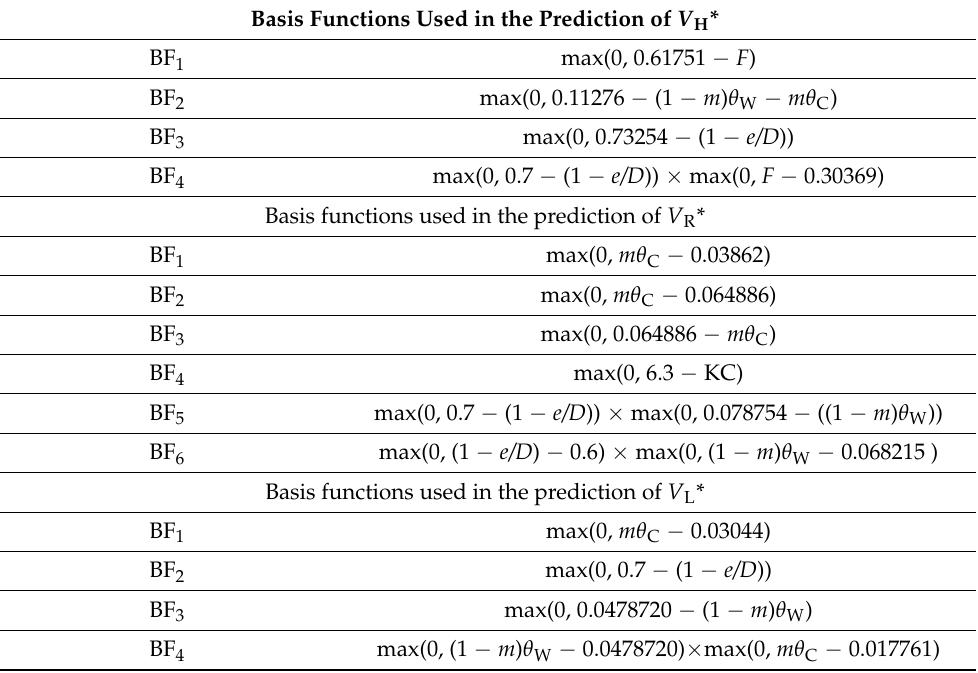
Table 6. Coefficients and basis functions for MARS models in scour depth